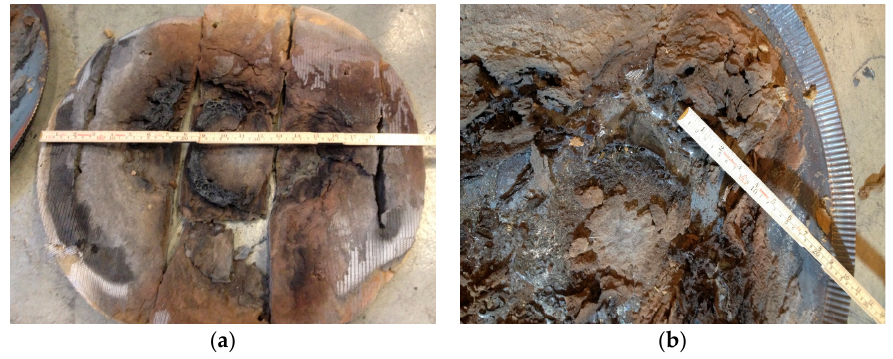
Figure 13. ( a ) Upper part of exposed thermal insulation after Test 2 and ( b ) lower part thermal insulation after Test 2. after Test